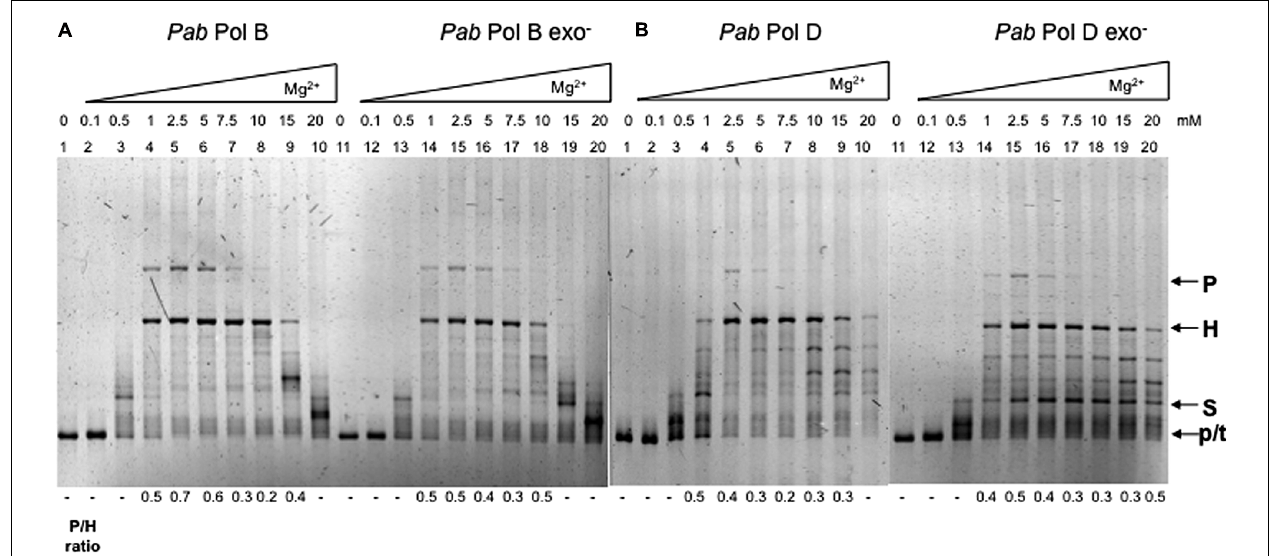
FIGURE 4 | Effect of magnesium concentration on Pab DNA polymerase slippage. Primer extension reactions were carried out as described in the “Materials and Methods.” Reactions contained 0.5 units of Pab PolB,